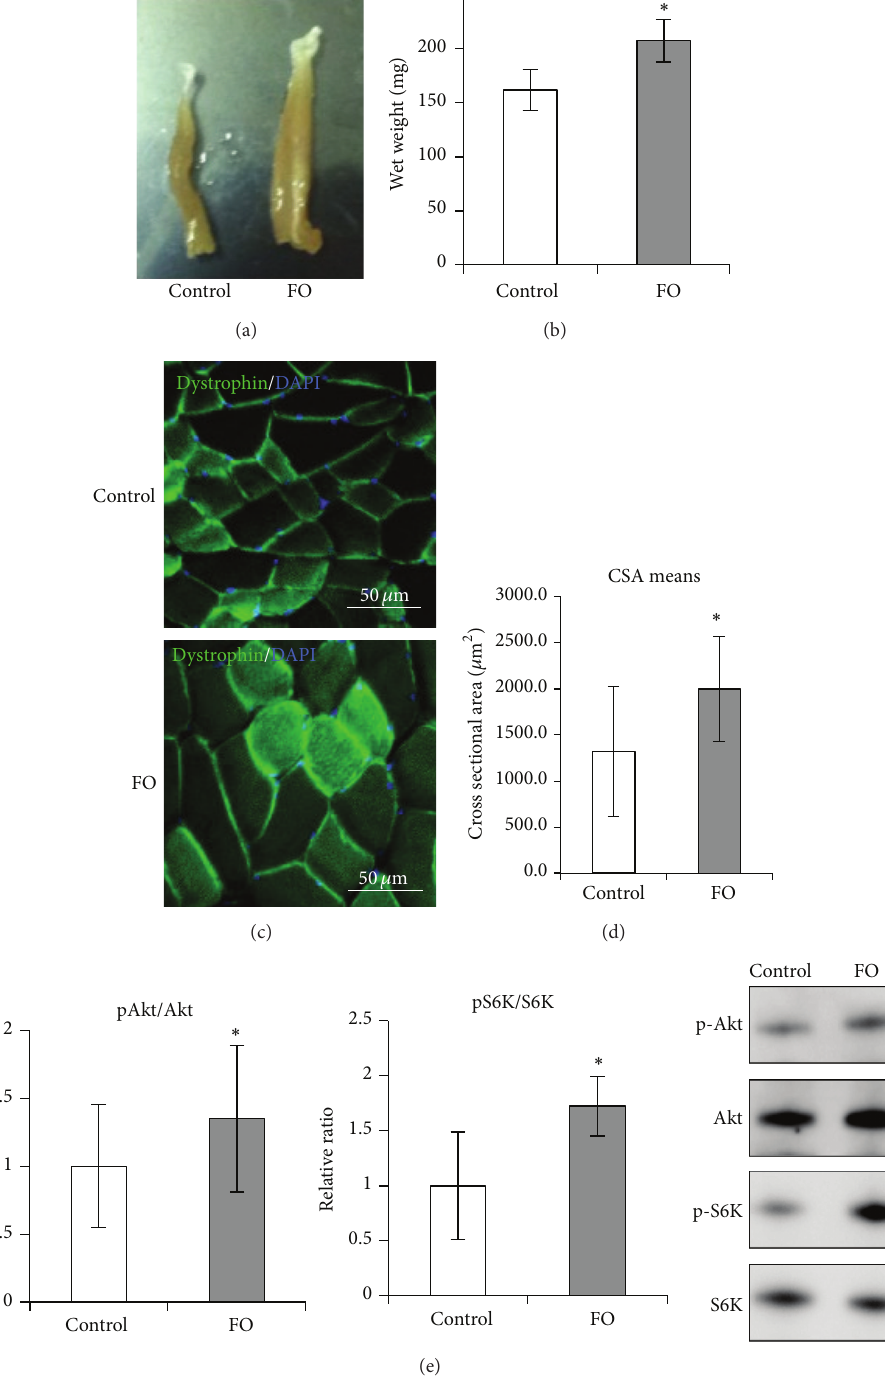
Figure 1: Skeletal muscle hypertrophy following functional overload. (a, b) Change in muscle weight following functional overload. A photograph of plantaris muscles isolated from control and FO groups (a) and a graph representing wet weight of plantaris in each group (b). (c, d) Change in cross-sectional area of plantaris following functional overload. Representative merged images of immunohistochemistry staining for Dystrophin (green) with DAPI from control and FO groups (c) and a graph plotting the means of cross-sectional area in each group (d) are shown. (e) Representations of Akt (Ser473) phosphorylation levels (left) and p70S6K (Thr389) phosphorylation levels (center), as detected by Western blot analysis. The typical blot patterns are described in the right panels. Phosphorylation levels were calculated to divide the signal of the phosphorylated form against the total protein expression for Akt or S6K. The relative ratio, normalized to the signal observed for the control group, is shown. All values are expressed as the mean ± SDM (𝑛 = 5) . Significant differences: ∗ compared to control group (𝑃 < 0.05)